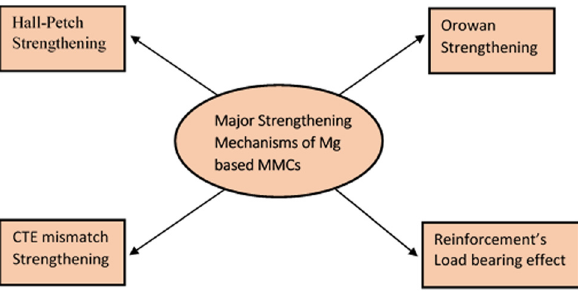
Figure 3: Strengthening mechanisms for ceramics - reinforced mag - nesium hybrid composites.